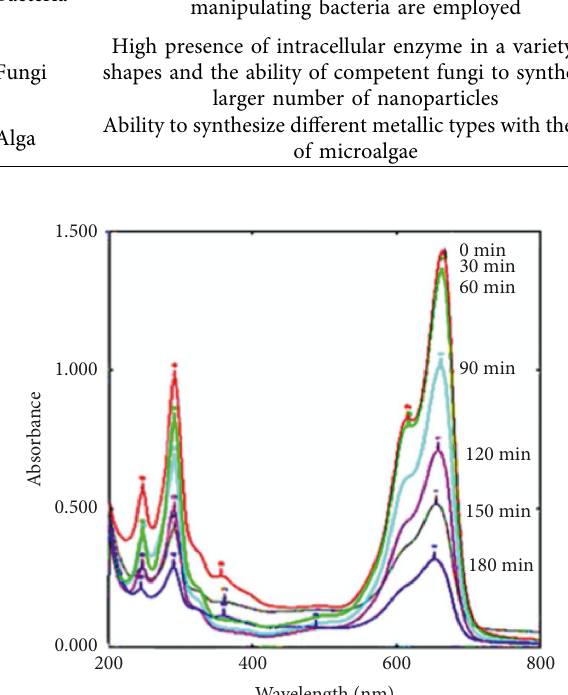
Figure 2: UV-Vis absorption spectra of photocatalytic degradation of methylene blue dye in the presence of green Ag NPs